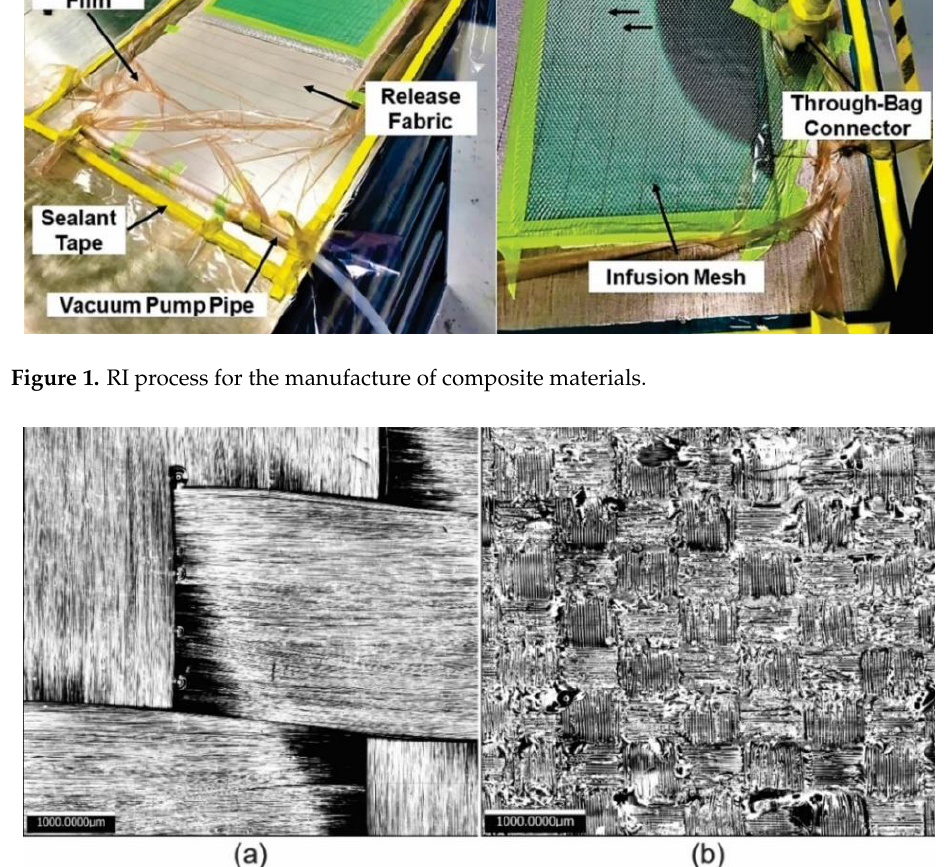
Figure 2. Optical microscopy of ( a ) carbon fiber and ( b ) glass fiber sheets.